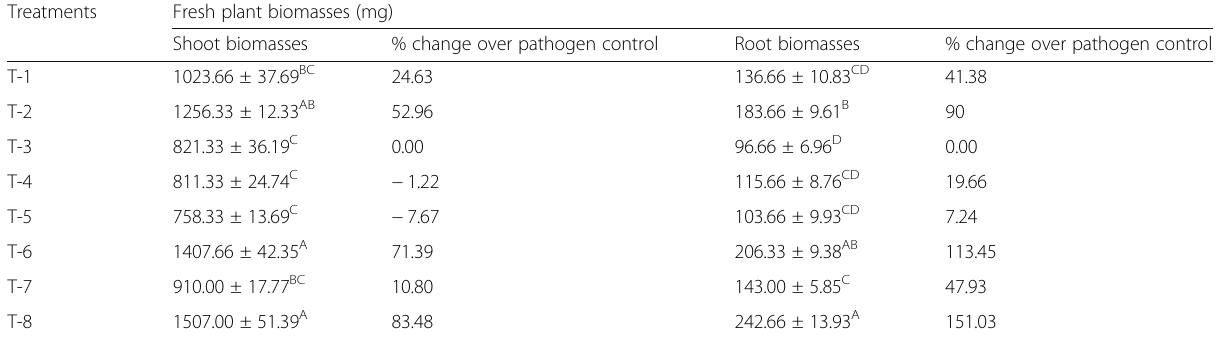
Table 3 Effect of seed inoculation with efficient chitinolytic bacteria on fresh biomasses of pigeon pea plants under pathogen pre- challenged conditions Treatments